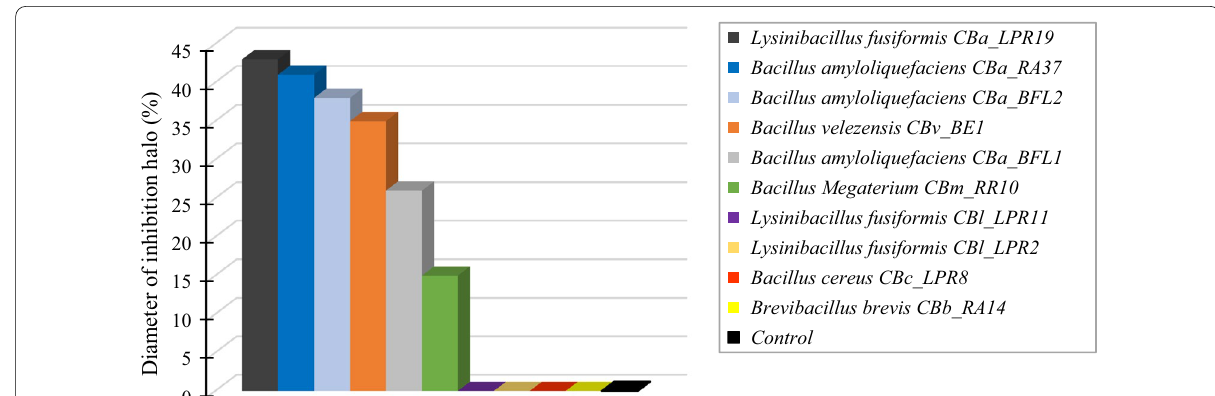
standard deviation ±